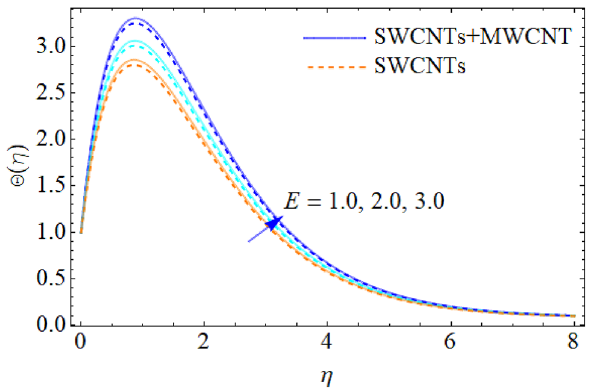
Figure 10. Influence of E on �(η) .